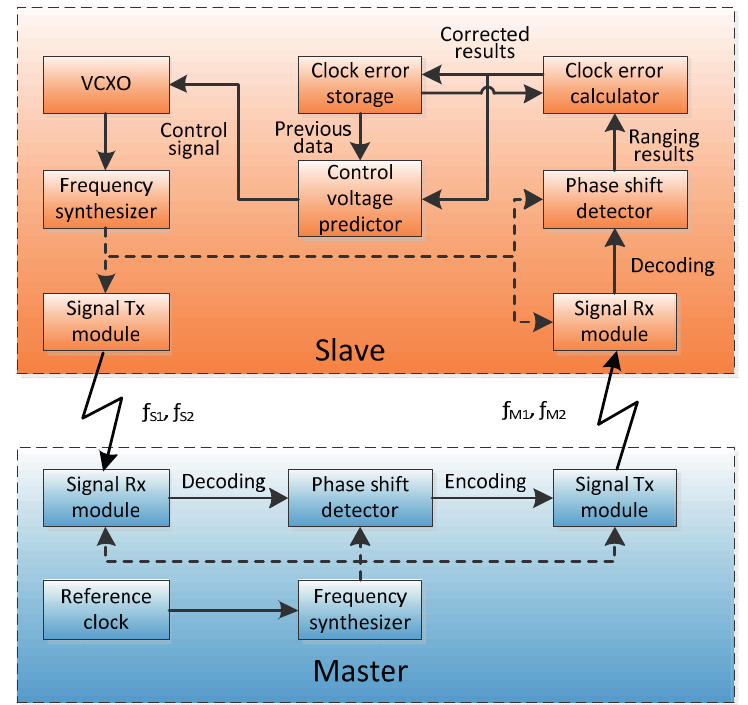
Figure 3. Schematic of the proposed system.